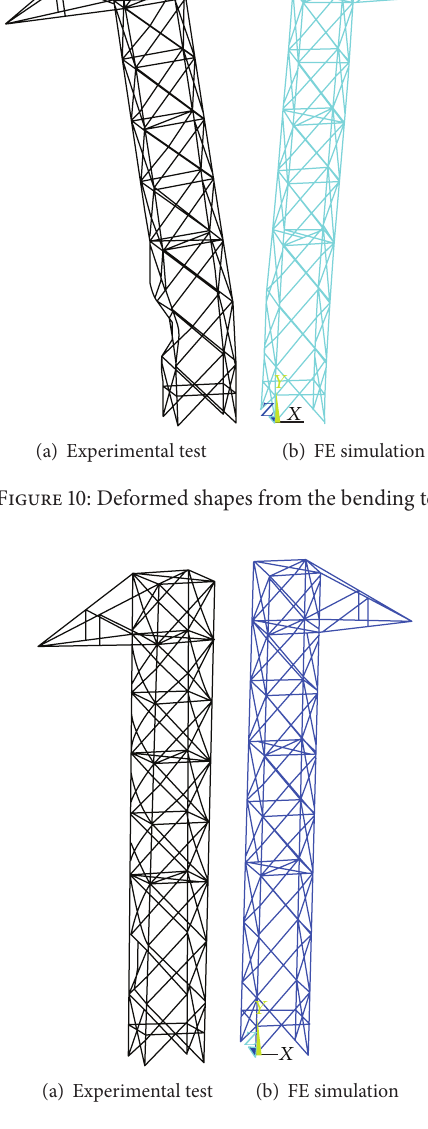
Figure 11: Deformed shapes from the torsional